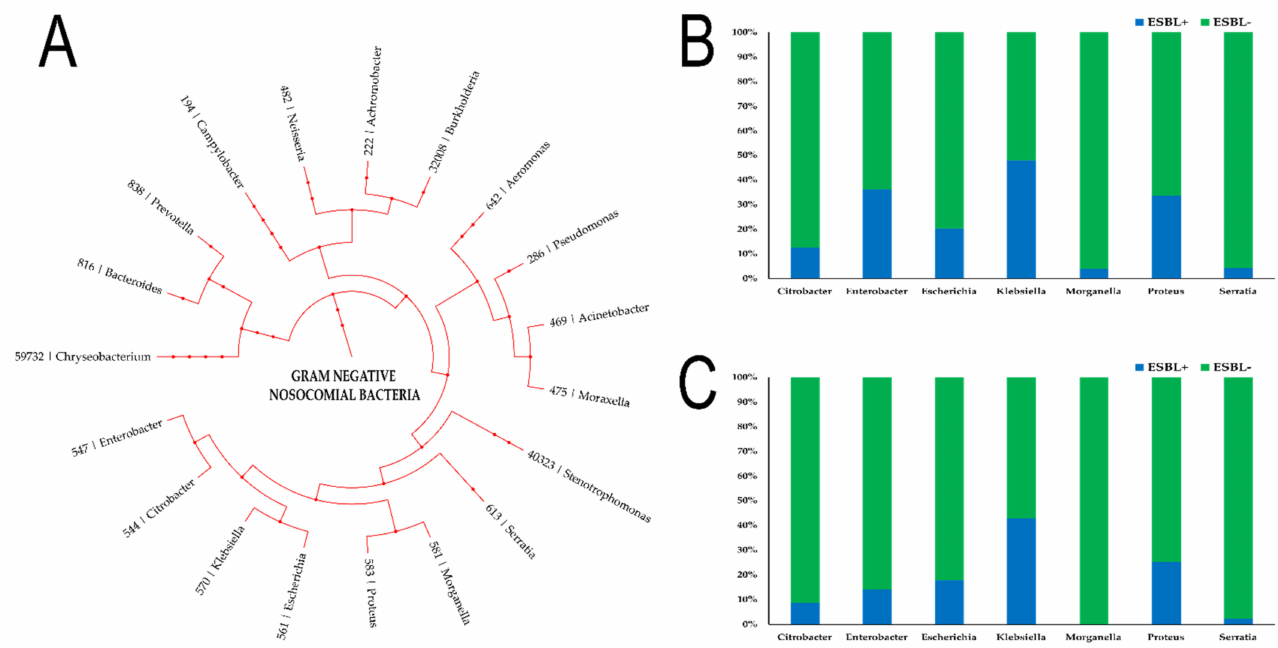
Figure 3. Percentage of isolates that were identified as Extended-Spectrum Beta-Lactamases positive (ESBL+). ( A ) Phy- logenetic tree showing the phylogenic relationship of the different gram-negative bacteria studied in the present study along with their respective NCBI Taxon ID; ( B ) Percentage (%) of isolates that were ESBL+ among different genera of Enterobacterales in 2017; ( C ) Percentage (%) of isolates that were ESBL+ among different genera of Enterobacterales in